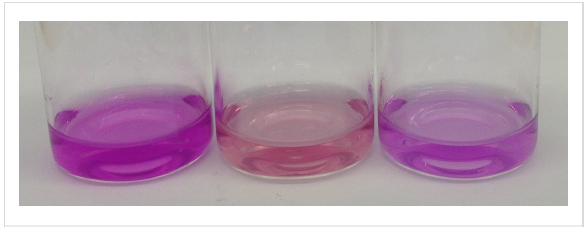
Figure 2: Solution of PEG-PP (0.05 mg/mL) a) at pH 10, b) in pres- ence of 16.7 equiv DPE-CD at pH 12, c) in presence of 100 equiv RAMEB-CD at pH 12 (from left to right).